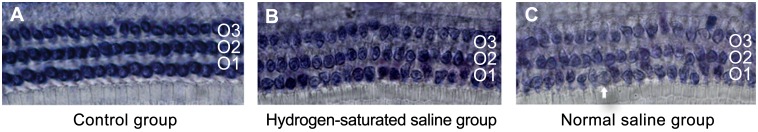
Surface preparation of the organ of Corti in the basal turn stained with SDH.Seven days after noise exposure, the cochleae were stained with SDH. The staining and the morphology of the hair cells in the hydrogen-saturated saline group were superior to the normal saline group. (A) Control group. (B) Hydrogen-saturated saline group. (C) Normal saline group. O1–3: outer hair cell layers. “↑”: dropsical hair cells.